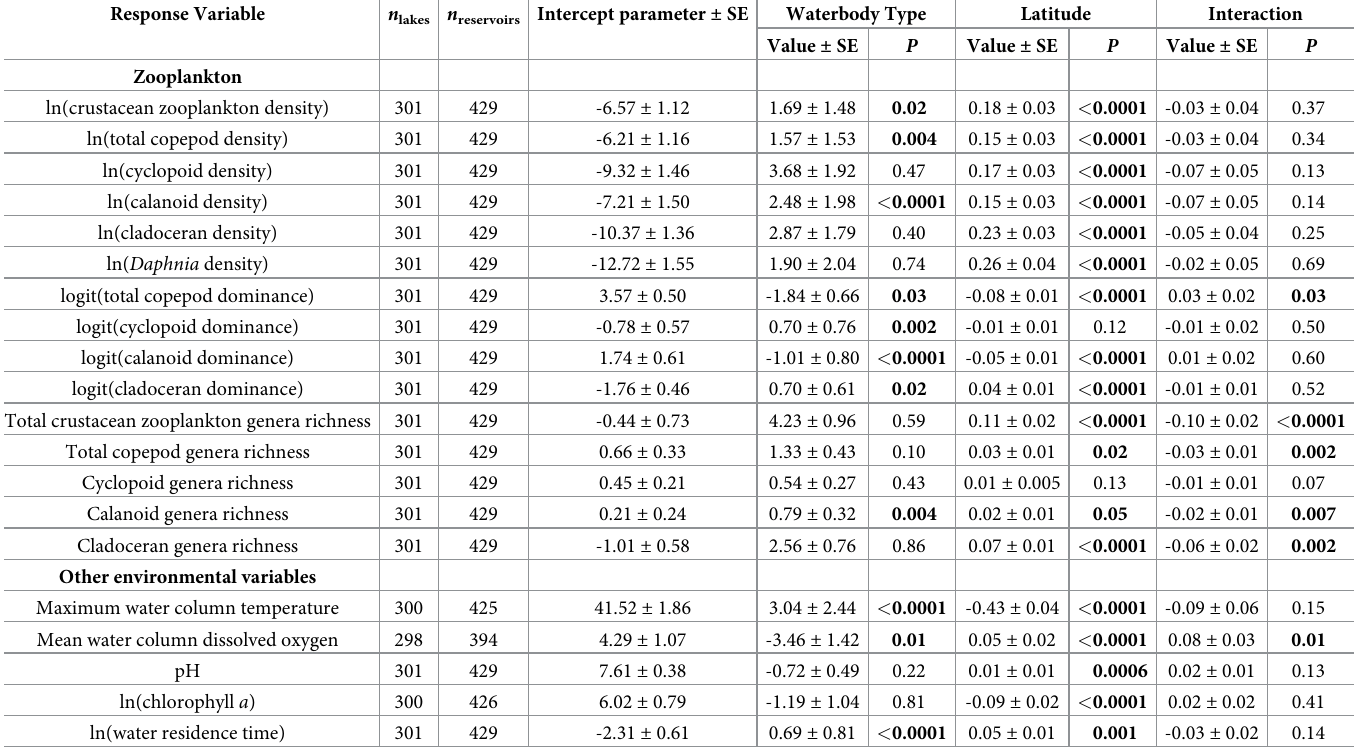
Table 2. Multiple linear regression model statistics for the effects of waterbody type as an indicator variable (with natural lakes coded as 0 and reservoirs coded as 1), latitude, and the interaction of waterbody type and latitude on zooplankton and other environmental